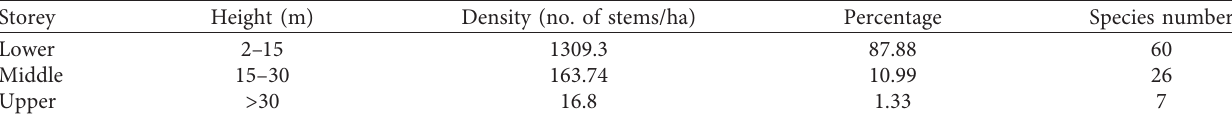
Table 3: Density and number of woody species by storey in Agama